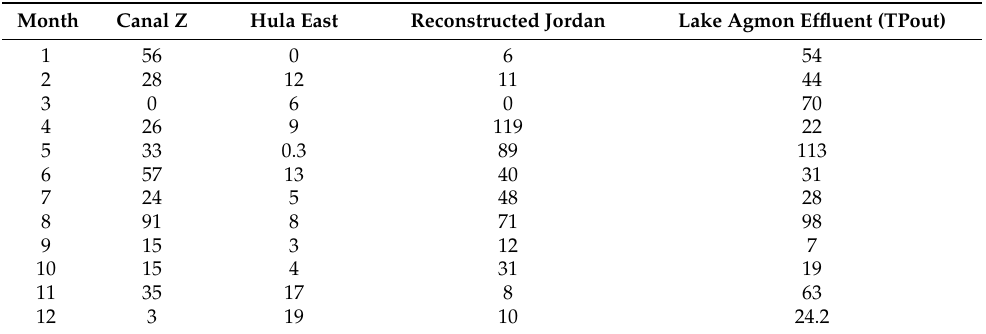
Table 5. Monthly averages of TP concentrations (ppb) in the water sources of Lake Agmon: Canal Z, Hula East, and Reconstructed Jordan (see Figures 1 and 2) during 2003.